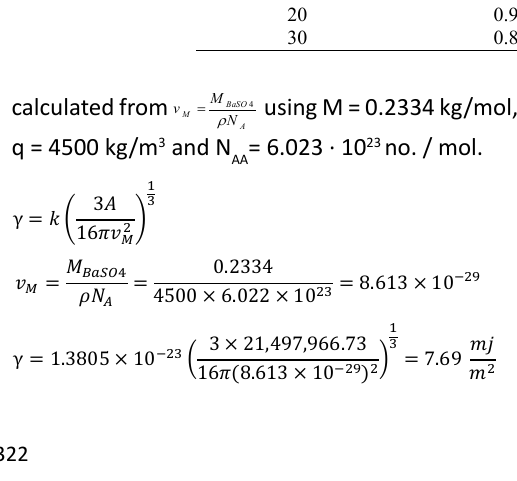
Fig. 6. BaSO crystallization in different Na 4 Table 3. R-Square comparison between primary and secondary nucleation theories